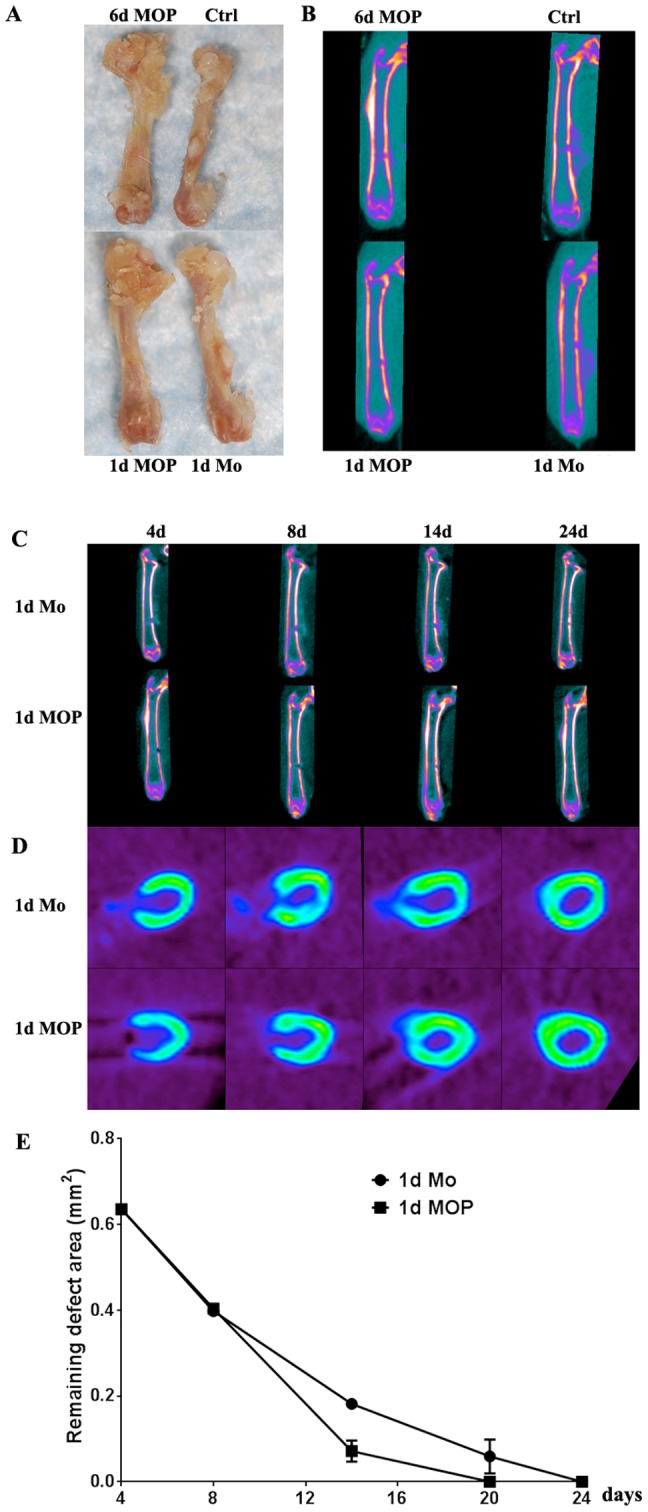
Monoosteophils accelerate cortical bone repair in the drilled-hole bone defect model.NOD/SCID mice were anesthetized with isoflurane, and holes (0.9 mm) were created in the mid-diaphysis of femur. A–B. Holes were filled with Matrigel (Ctrl), Matrigel +6 d Monoosteophils (6 d MOP, 3×106 cells), Matrigel+1 d Monoosteophils (1 d MOP, 3×106 cells), or Matrigel +1 d Monocytes (1 d Mo, 3×106 cells). After 14 days, femurs were harvested and observed by visual analysis (A) and low resolution µCT (B). C–D. Holes were filled with Matrigel+1 d Monoosteophils (1 d MOP, 3×106 cells) or Matrigel +1 d Monocytes (1 d Mo, 3×106 cells). Bone repair was monitored by serial µCT using coronal (C) and transverse plane imaging (D) and quantitated as remaining defect area (mm2) (E) at days shown in the figure.